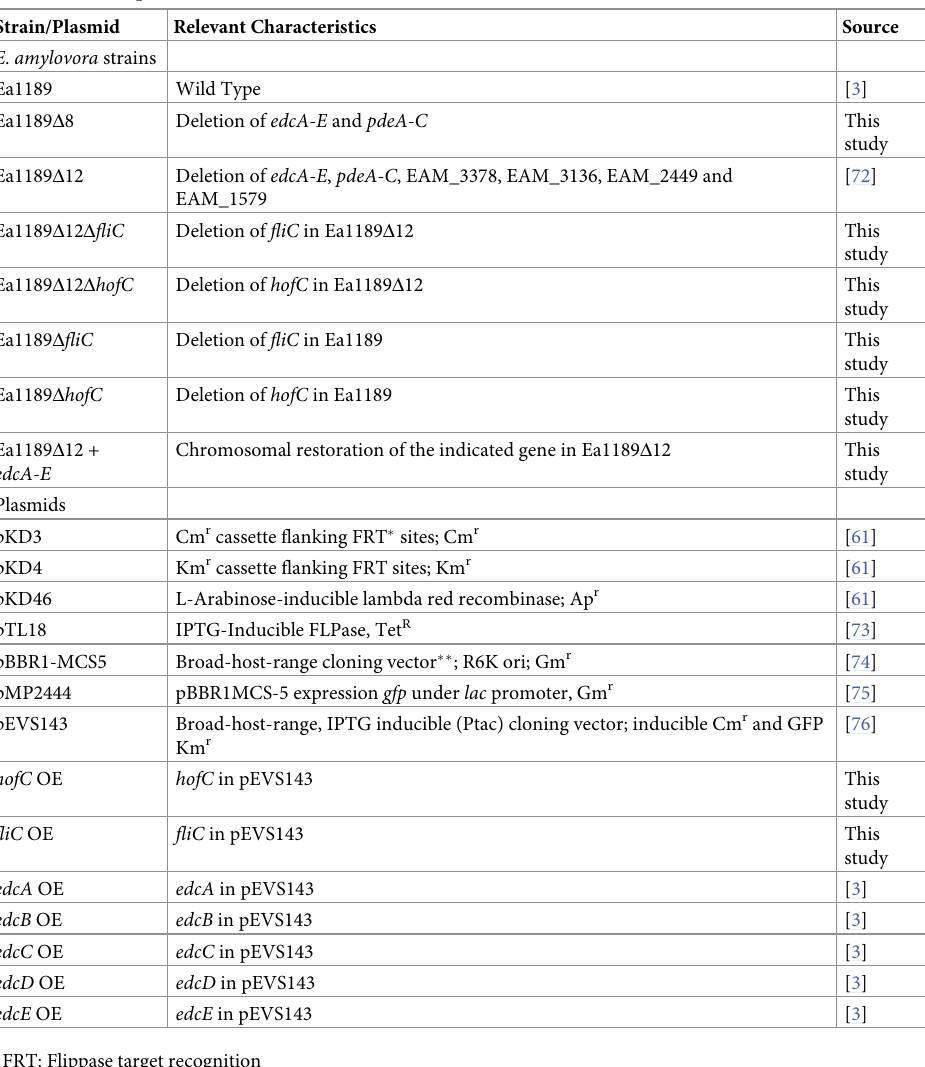
Table 8. Strains, plasmids and relevant